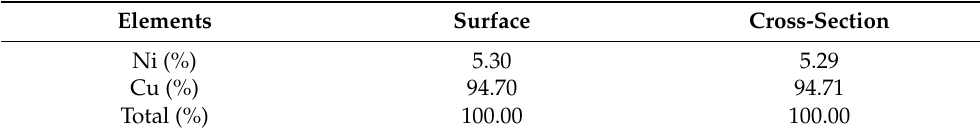
Figure 2. ( a ) SEM image of the cross-section and ( b , c ) corresponding EDS mappings of Cu and Ni elements, respectively, ( d ) SEM image of the surface and ( e , f ) corresponding EDS mappings of Cu and Ni elements, respectively. Table 2. Metal content in different regions of Cu-Ni